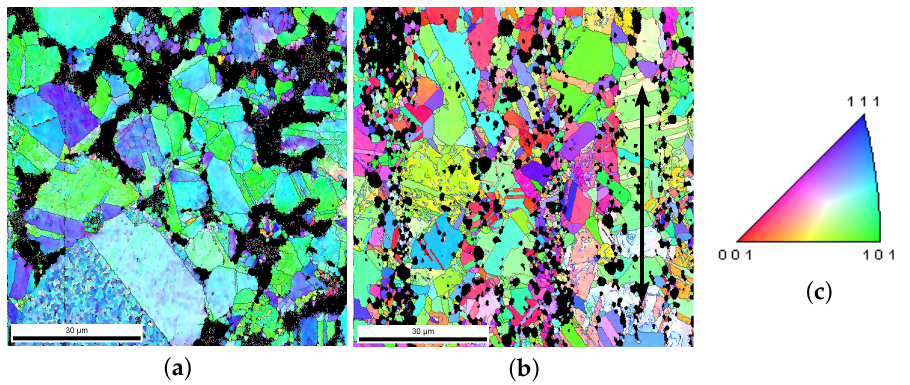
Figure 1. ( a ) The green body morphology of the PM12-2 composite before hot extrusion [26]; ( b ) the microstructure of PM12-2 in the longitudinal direction after hot extrusion (Table 1), where the arrow presents the extrusion direction; ( c ) grain orientation color code valid for the Ag phase of all the EBSD measurements for Ag/SnO 2